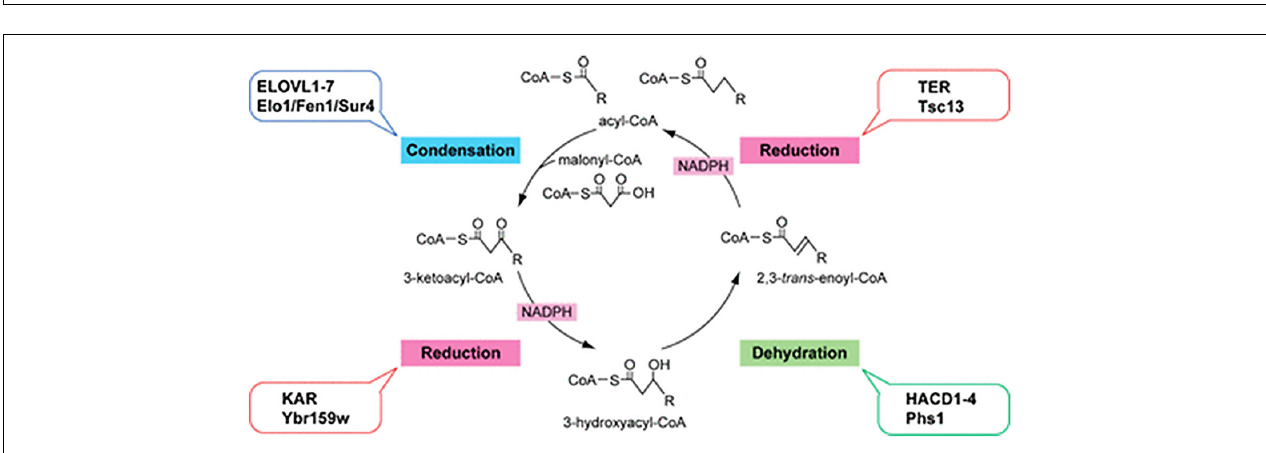
FIGURE 3 | Fatty acid elongation by the ELOVL family of enzymes. Diagram of the four-step fatty acid elongation cycle indicating the mammalian (ALL CAPITALS) and the yeast enzymes involved in each step. The ELOVL family elongasaes catalyze the initial condensation reaction (Kihara, 2012; figure used with permission).